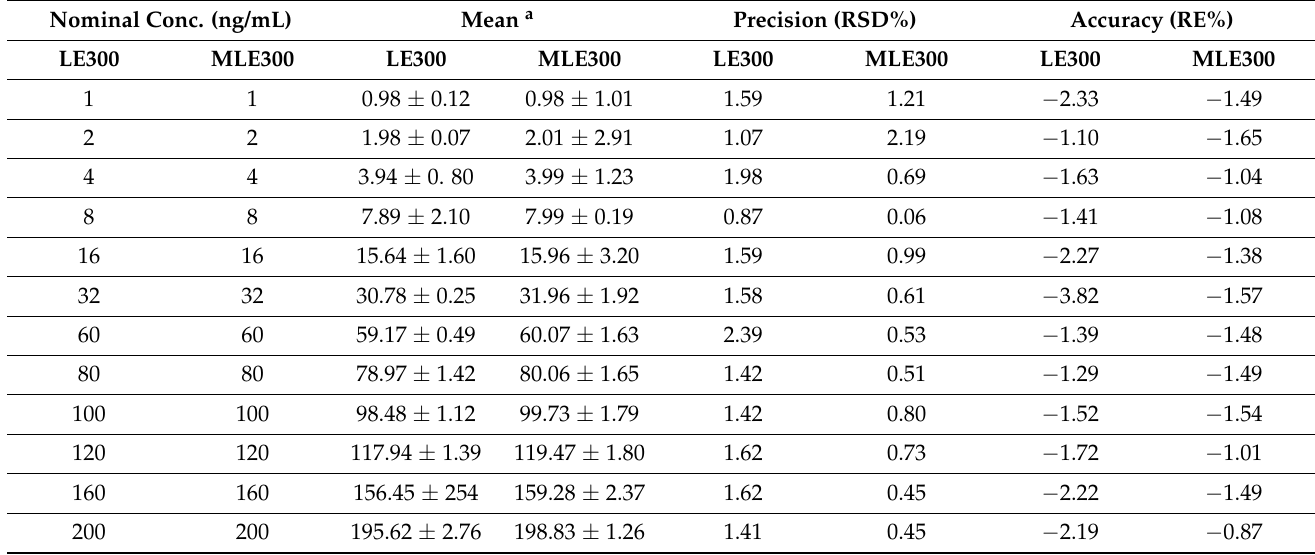
Table 3. Back-calculated data of LE300 and MLE300 of the calibration levels from rat plasma. Nominal Conc. (ng/mL)